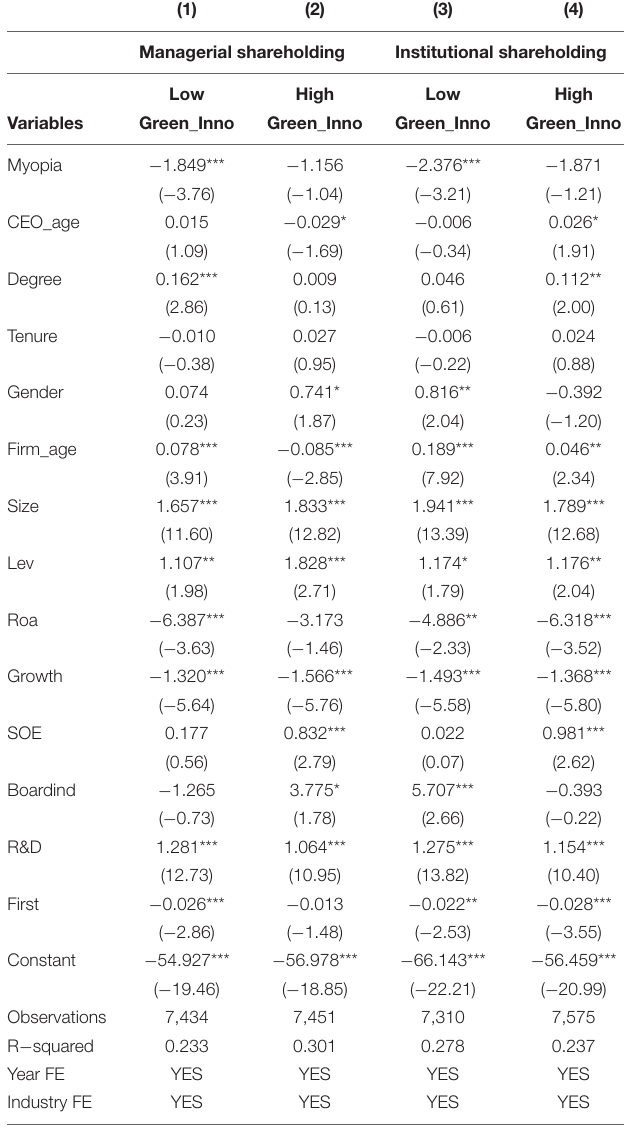
TABLE 5 | The moderating role of equity incentive and institutional